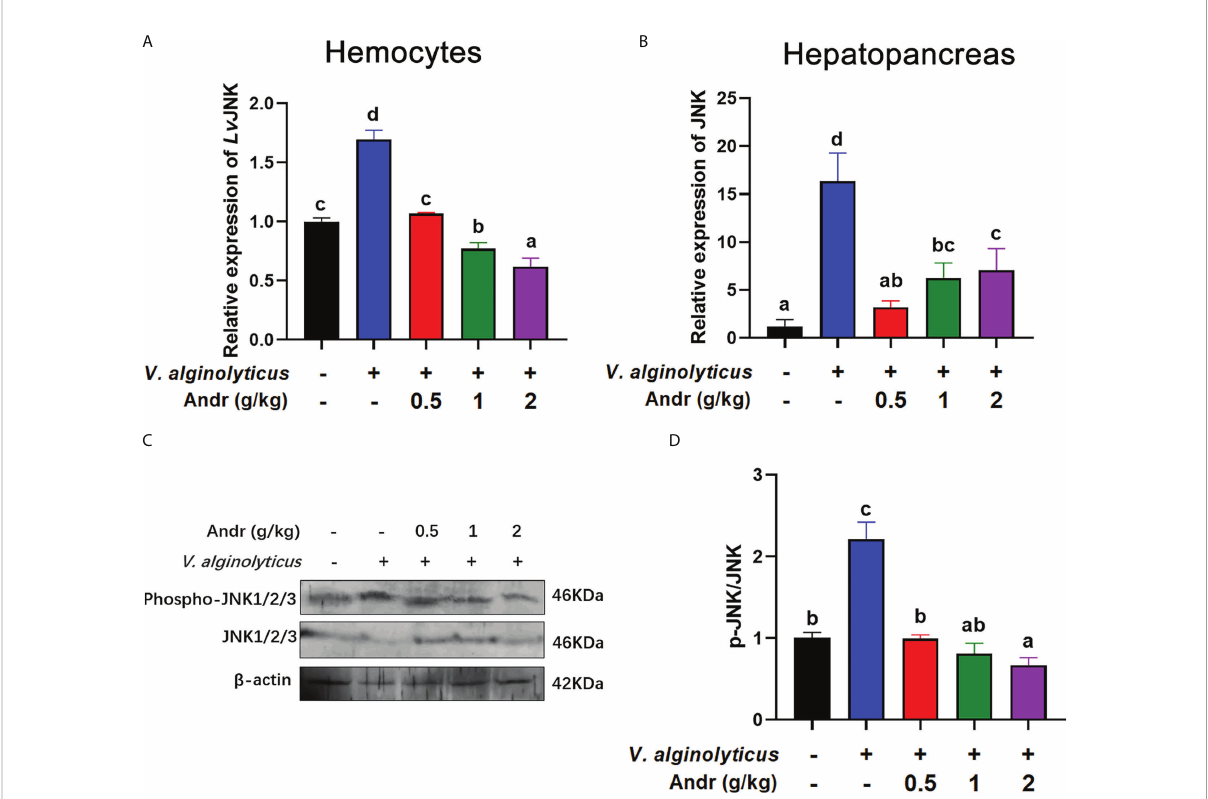
FIGURE 7 Andr inhibited JNK activation induced by V. alginolyticus infection on L. vannamei . (A, B) The gene expression of JNK in hemocytes and hepatopancreas detected by qPCR. (C, D) The expressions of JNK, p-JNK in hepatopancreas were analyzed by Western blot. Values are means ± SD. a,b,c,d Value bars not sharing the same superscript letter are signi fi cantly different as evaluated by Duncan ‘ s test ( p <